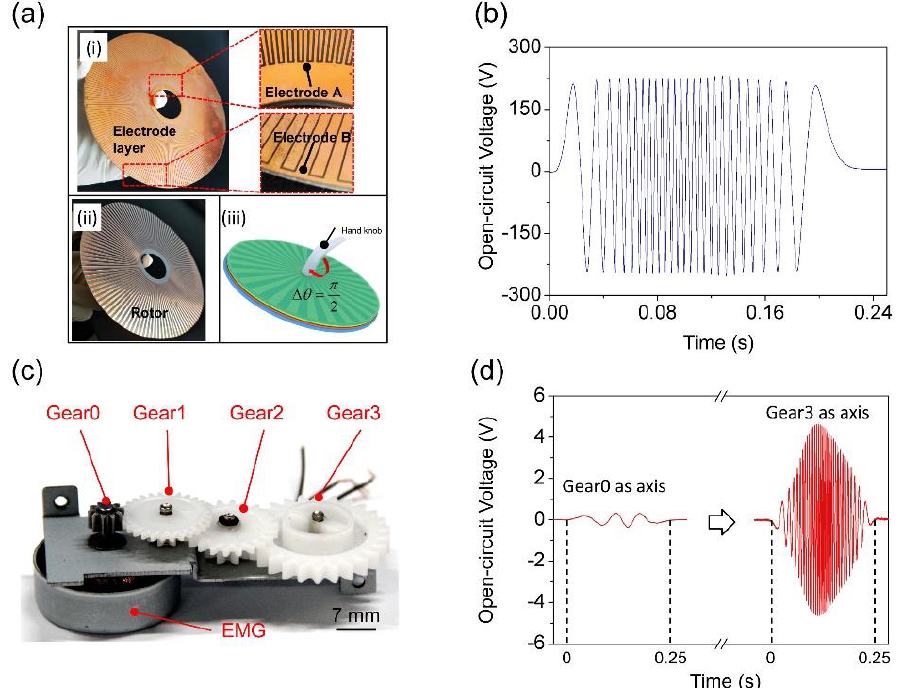
Figure 3. The measured electrical output of pr − TENG and EMG. ( a ) Photographs of the rotor and electrode layer, and the schematic diagram of the pr − TENG; ( b ) open-circuit voltage of the pr − TENG at a rotation speed of 50 rpm; ( c ) photograph of a commercial three-phase alternator for comparison; ( d ) open-circuit voltage of the EMG at a rotation speed of 50 rpm.